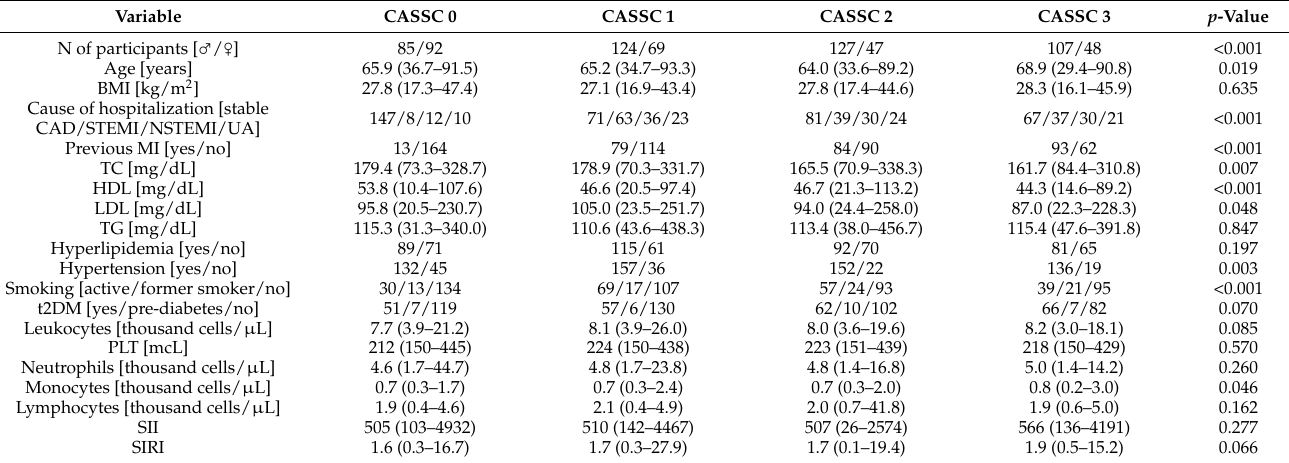
Table 2. Association between selected parameters and CAD